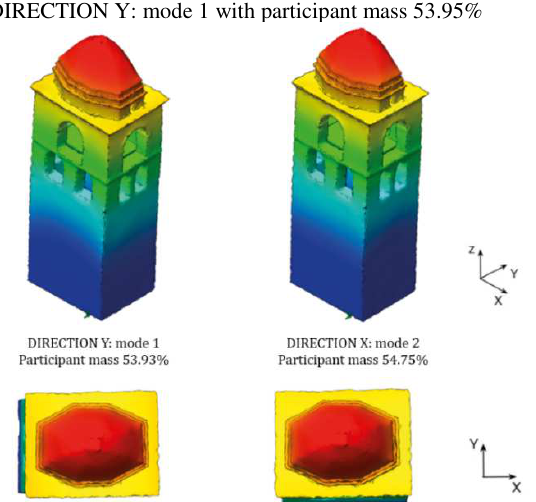
Figure 11 - Main mode shapes of vibration of two materials